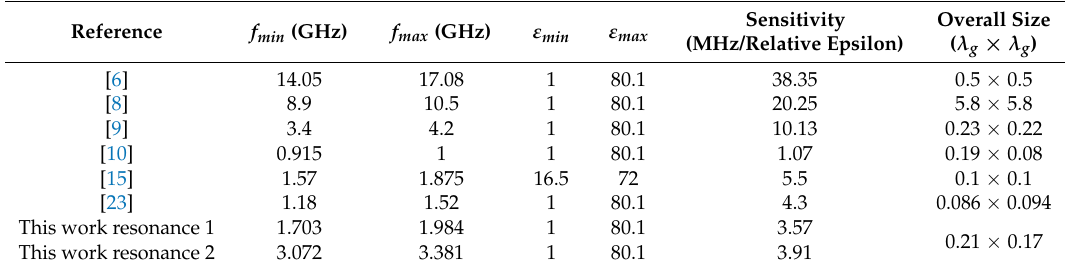
Table 2. Comparison of the characteristics of the proposed sensor and other recently published microwave microfluidic sensors with resonance shift operating